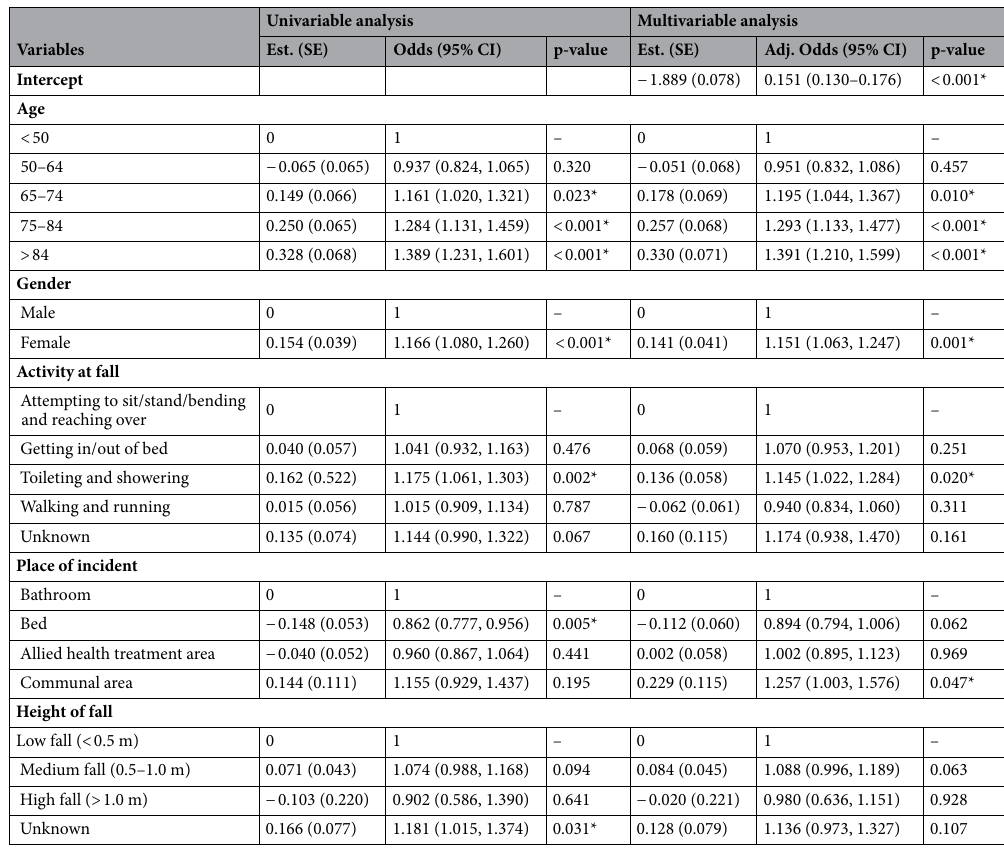
Table 2. Univariable and multivariable analysis of demographic and environmental risk factors associated with the severity level of fall. *Denotes significant association at 5% level of